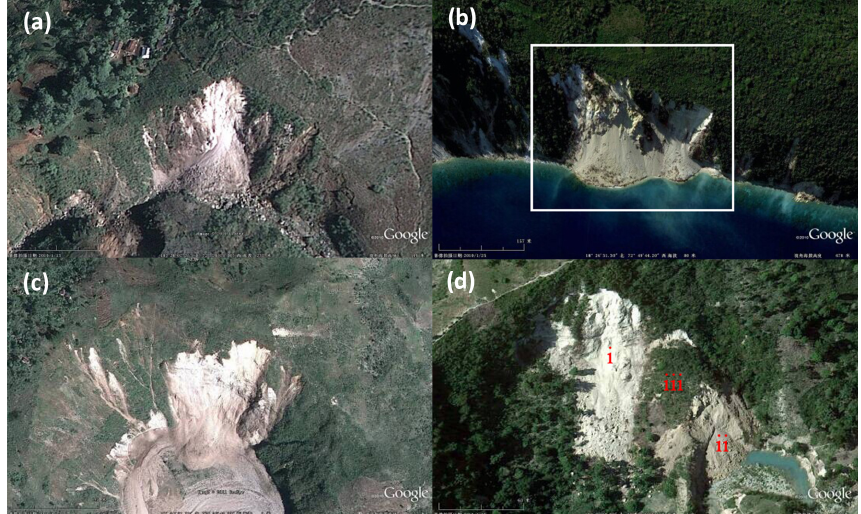
Figure 8. (a) and (b) are two rock falls occurred at (18 ◦ 28 0 07.75 00 N, 72 ◦ 29 0 15.00 00 W) and (18 ◦ 26 0 31.30 00 N, 72 ◦ 49 0 44.20 00 W), respec- tively. (a) was taken on 13 January 2010 (upward is northeast) and (b) was taken on 25 January 2010 (upward is south). (c) is located at 18 ◦ 28 0 51.78 00 N, 72 ◦ 26 0 42.00 00 W, and was taken on 13 January 2010 (upward is north). (d) shows several rock falls at 18 ◦ 19 0 38.90 00 N, 72 ◦ 40 0 01.32 00 W, and the images was taken on 25 January 2010 (upward is